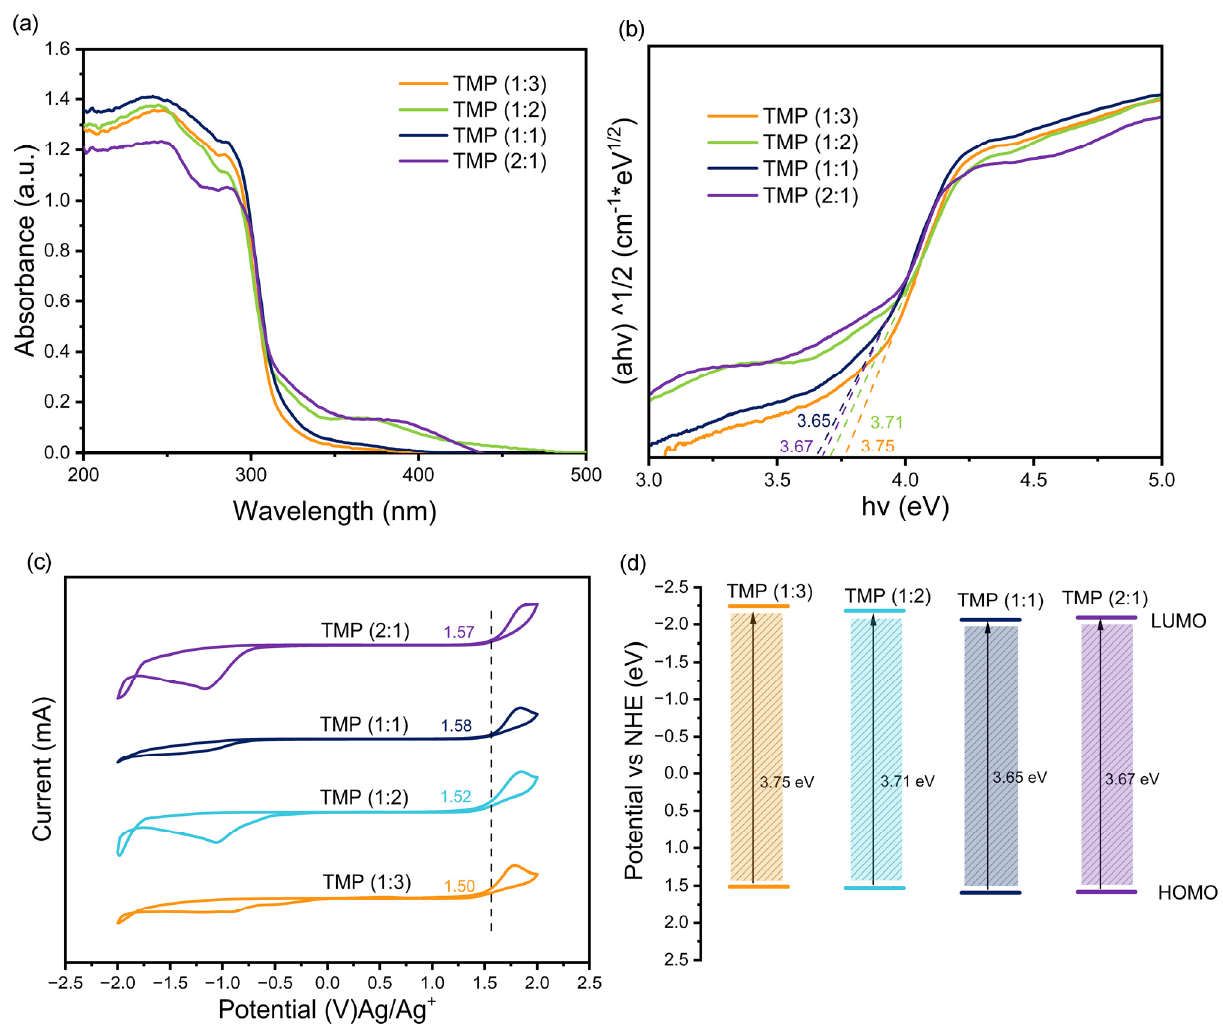
Figure 4. ( a ) Ultraviolet–visible diffuse reflectance spectroscopy (UV-Vis DRS) of the TMP. ( b ) Diagram of the Kubelka–Munk function of the TMP versus the absorbed light energy (band gap width). ( c ) Cyclic voltammogram (CV) of TMP. ( d ) Location of TMP highest occupied molecular orbital (HOMO) and lowest unoccupied molecular orbital (LUMO).